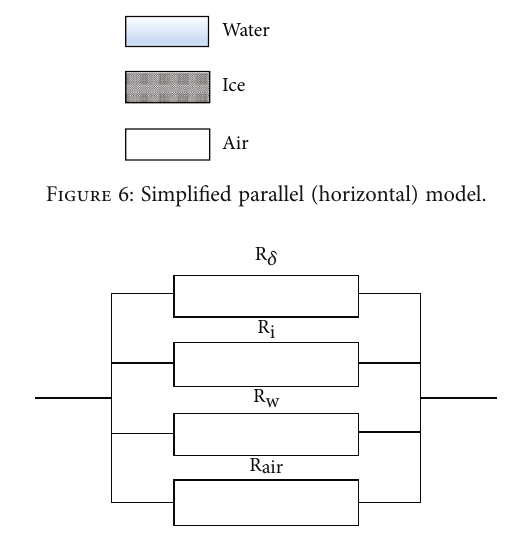
Figure 7: Thermal resistance analysis of parallel (horizontal) model.